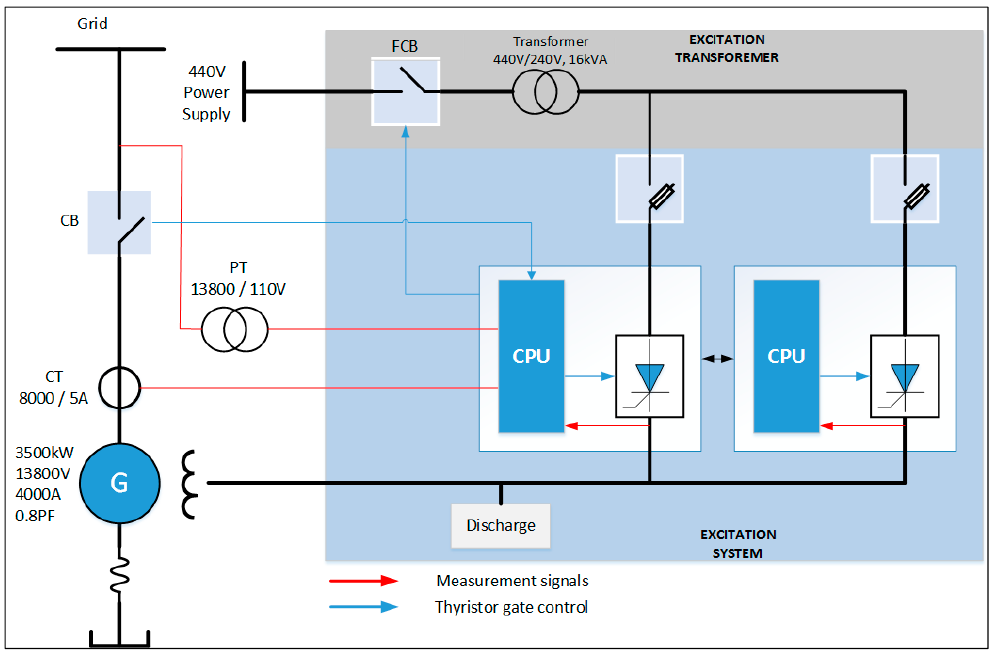
Figure 5. Excitation system architecture.